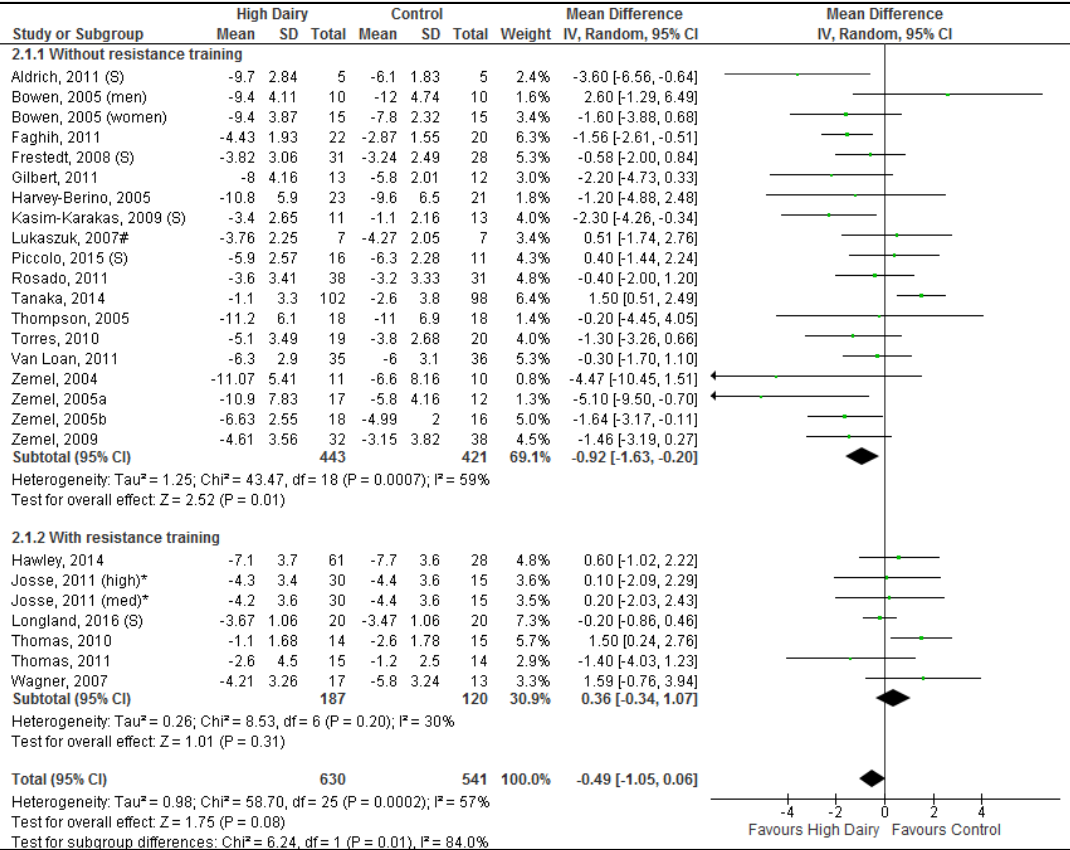
Figure 2. Forrest plot of mean (95% confidence interval (CI)) weighted differences in body weight (kg) between high dairy and control groups stratified for sub ‐ groups with resistance training vs. without resistance training. Results when Tanaka, 2014 [41] excluded: − 1.10 kg [ − 1.65, − 0.56 kg], Z = 3.99 ( p < 0.001); Heterogeneity: Chi 2 = 21.56, degrees of freedom ( df ) = 17 ( p = 0.20). (S) The intervention was dairy supplements; # The comparison group was soy protein; * Sample size adapted for multiple comparisons to avoid data duplication; med, medium dairy group; high, high dairy group.